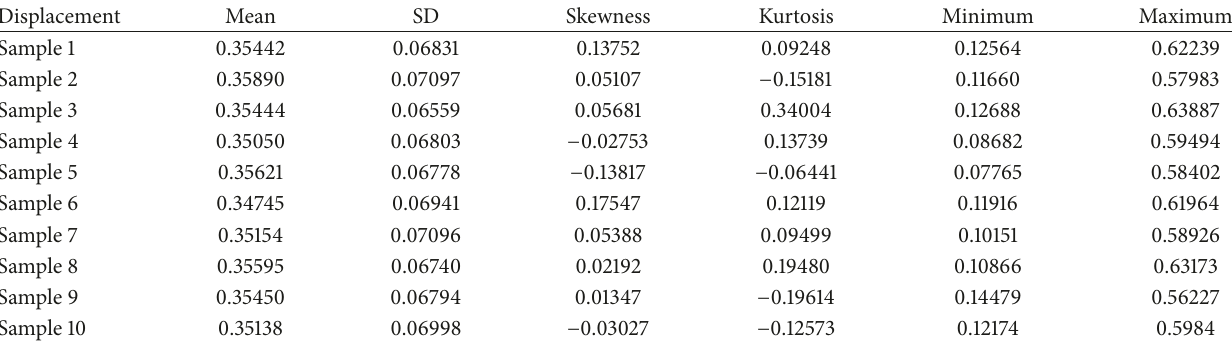
Table 6: Statistics of 10 samples parameters of the single high tower top node 35# Ux displacement time history under wind field 1 (m).